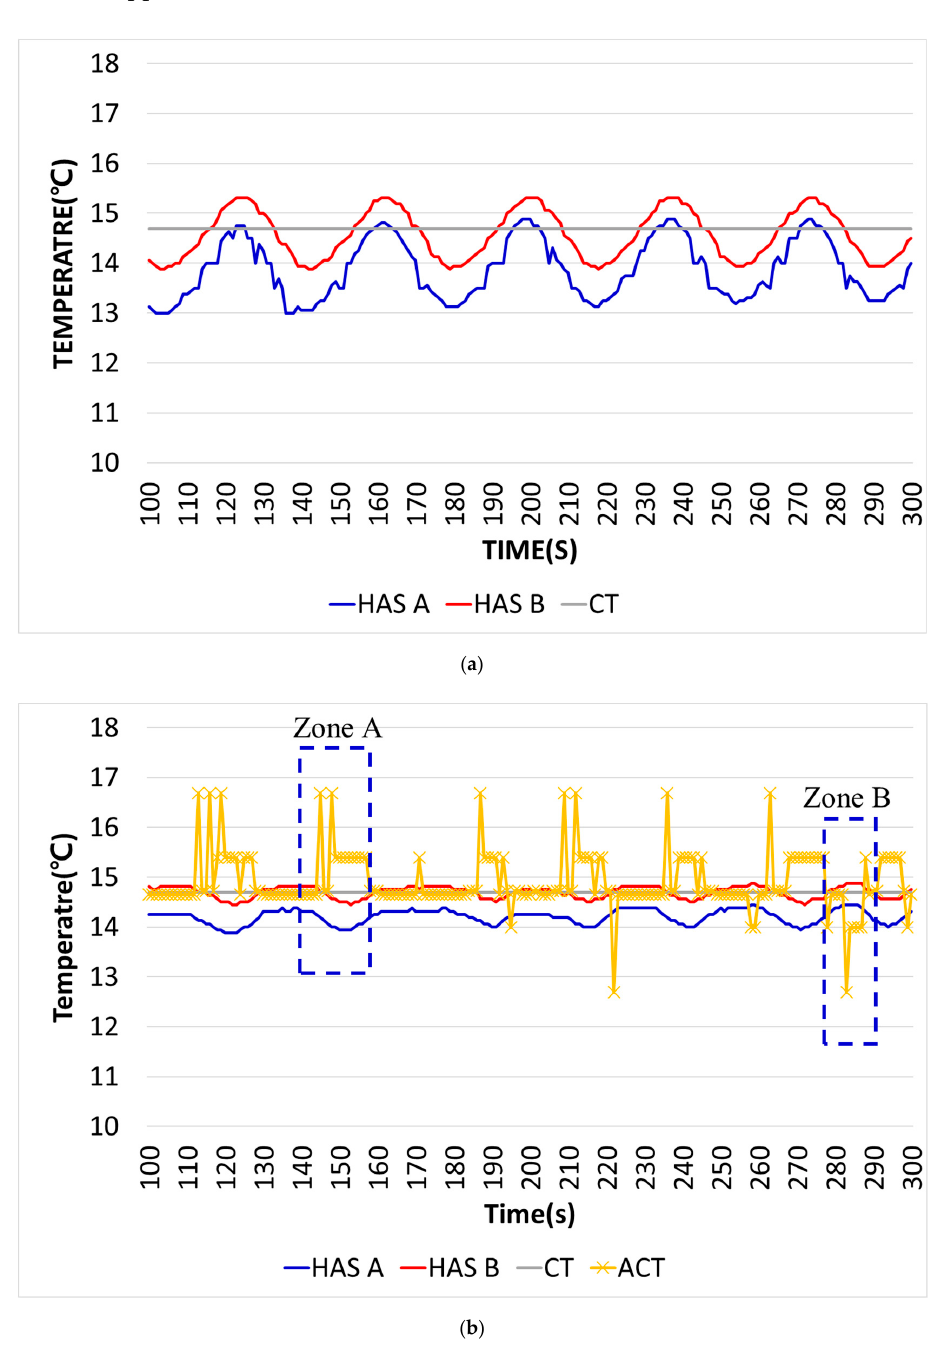
Figure 14. Temperature comparison in steady-state. ( a ) PI Controller. ( b ) SF-PI Controller.